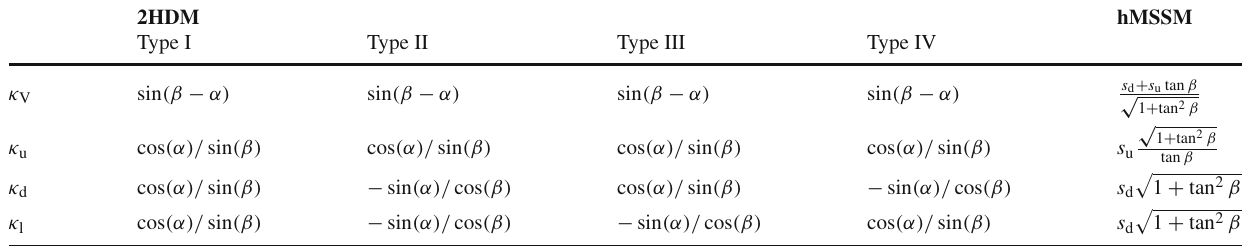
Table13 ModificationstothecouplingsoftheHiggsbosonstoup-type ( κ u ) and down-type ( κ d ) fermions, and vector bosons ( κ V ), with respect to the SM expectation, in 2HDM and for the hMSSM. The coupling